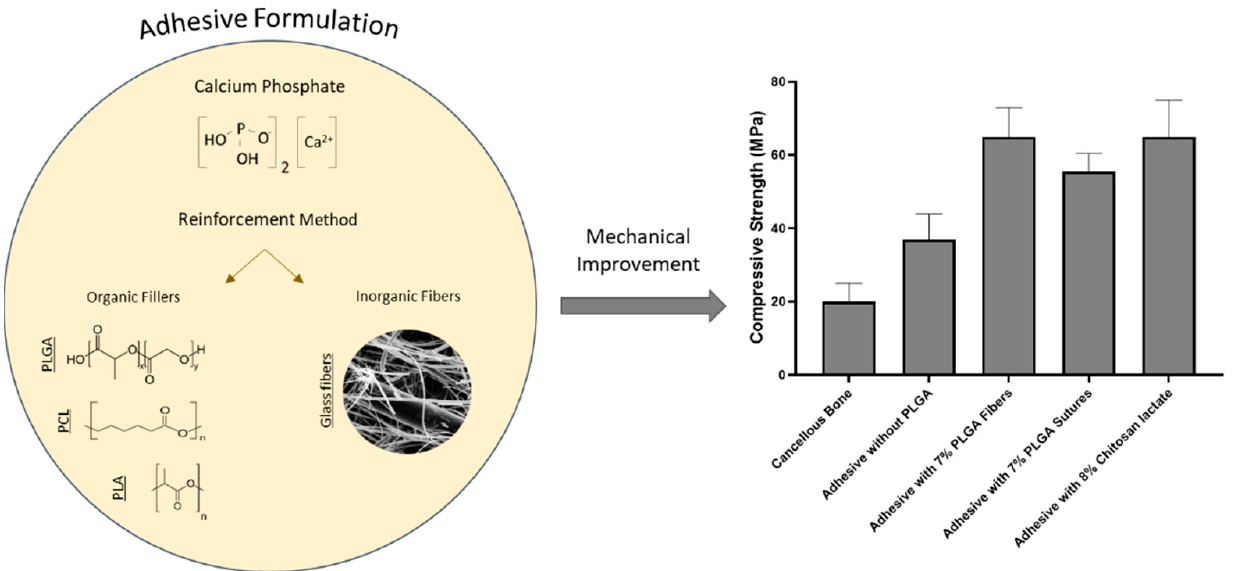
Figure 12. Improved mechanical properties can be achieved by incorporating organic (e.g., poly(lactic acid) (PLA), poly(glycolic acid) (PGA), poly(lactic-co-glycolic acid) (PLGA) and PCL)) and/or inorganic additives (e.g., glass fibres) to adhesives, thereby making them suitable to treat long bone fractures of the extremities.